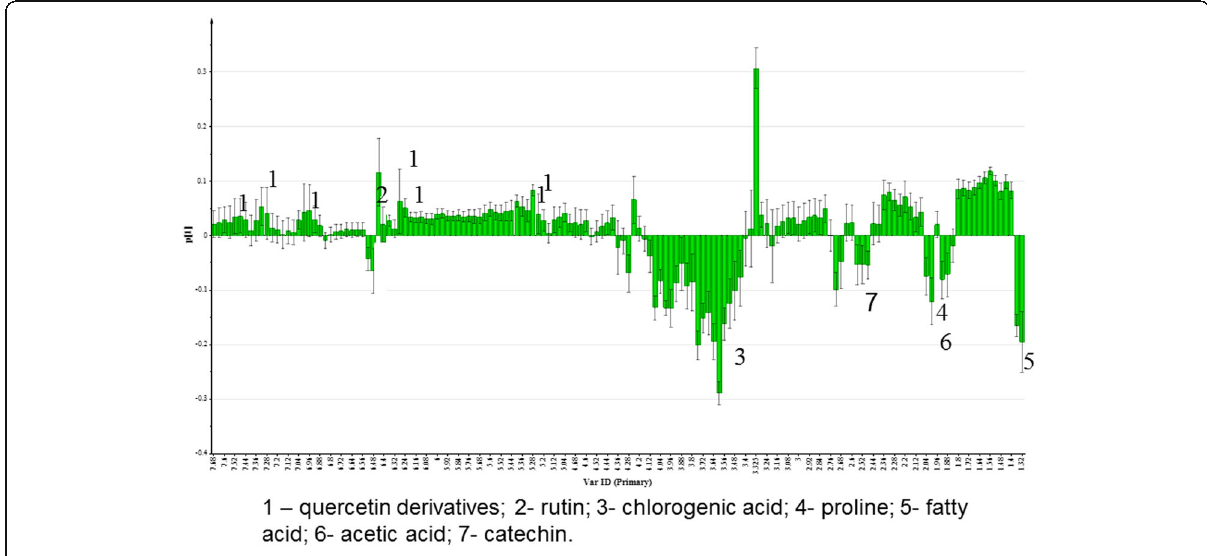
Fig. 3 PCA loading column plot of the 1 H NMR data of the various EtOH:water extracts. 1 – quercetin derivatives; 2 - rutin; 3 - chlorogenic acid; 4 - proline; 5 - fatty acid; 6 - acetic acid; 7 -